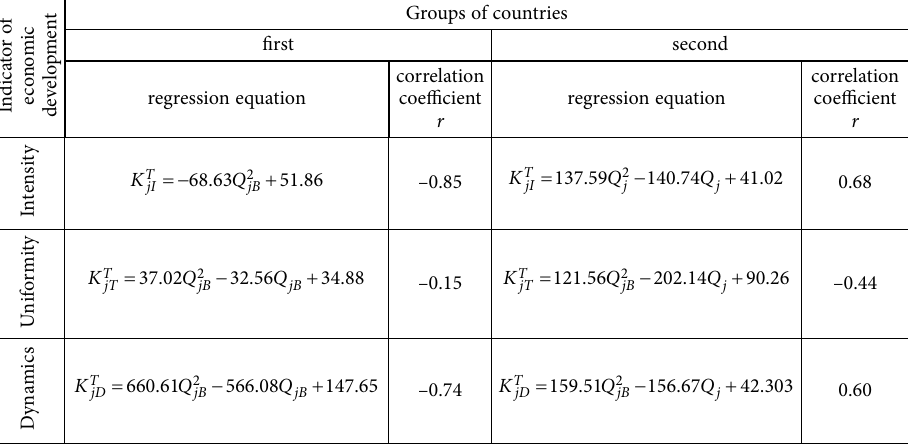
Table 4. Results of a correlation-regressive analysis of the impact of the economic development situ- ation in the euro area in the European Union on its indicators in the base year (source: compiled by the